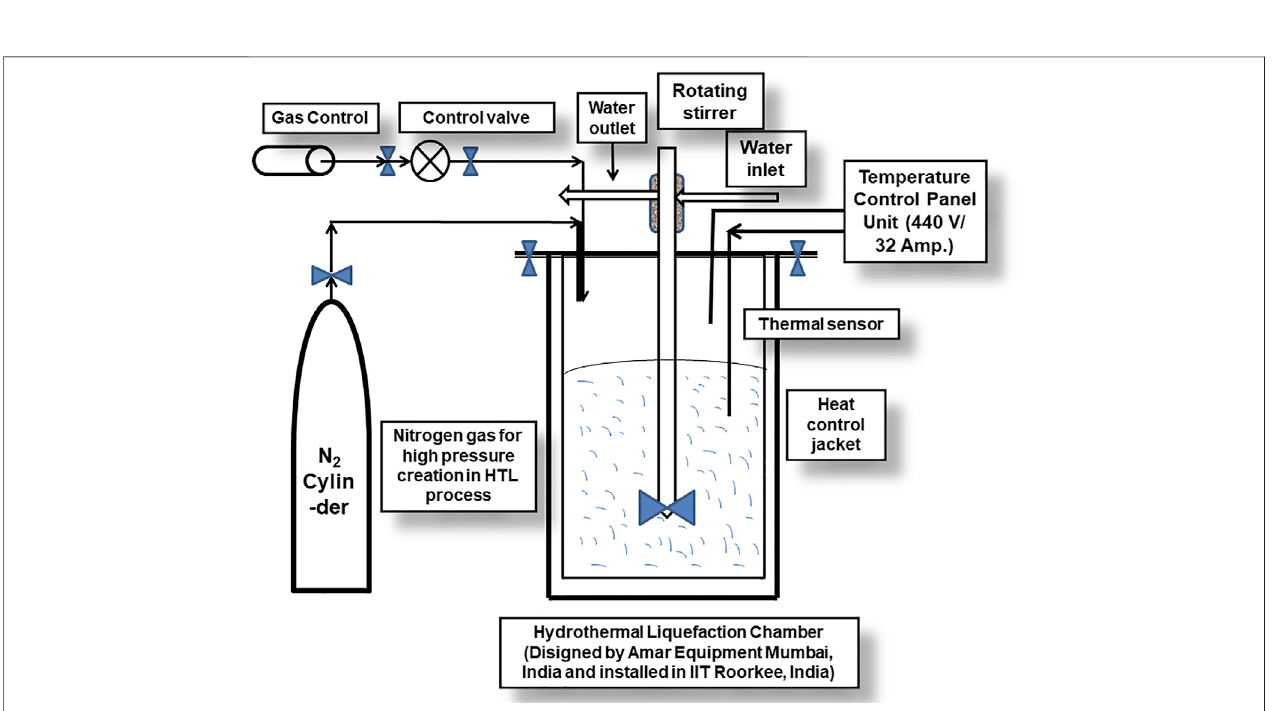
FIGURE 3 | Schematic diagram of a hydrothermal equipment (batch reactor designed by Amar Equipments Mumbai and installed in IIT Roorkee) highlighting its different parts/componants.